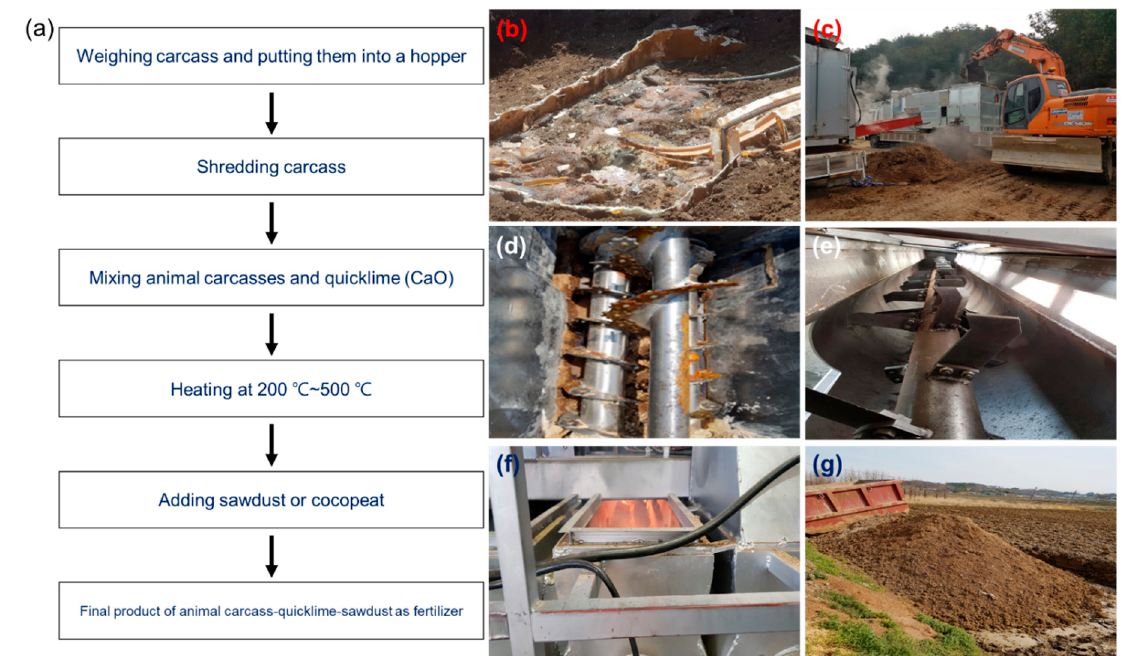
Figure 1. ( a ) Flow chart of the treatment process in thermo-chemical treatment machinery, ( b ) animal carcass buried in fiber-reinforced plastic before treatment, ( c ) placing a carcass into the hopper, ( d ) shredding carcass, ( e ) mixing the crushed product with quicklime, ( f ) heating to 200 °C to 500 °C, ( g ) final product comprising animal carcass-quicklime-sawdust mixture for use as compost.